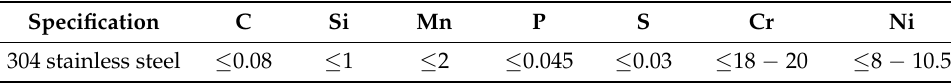
Table 1. The chemical composition of 304 stainless